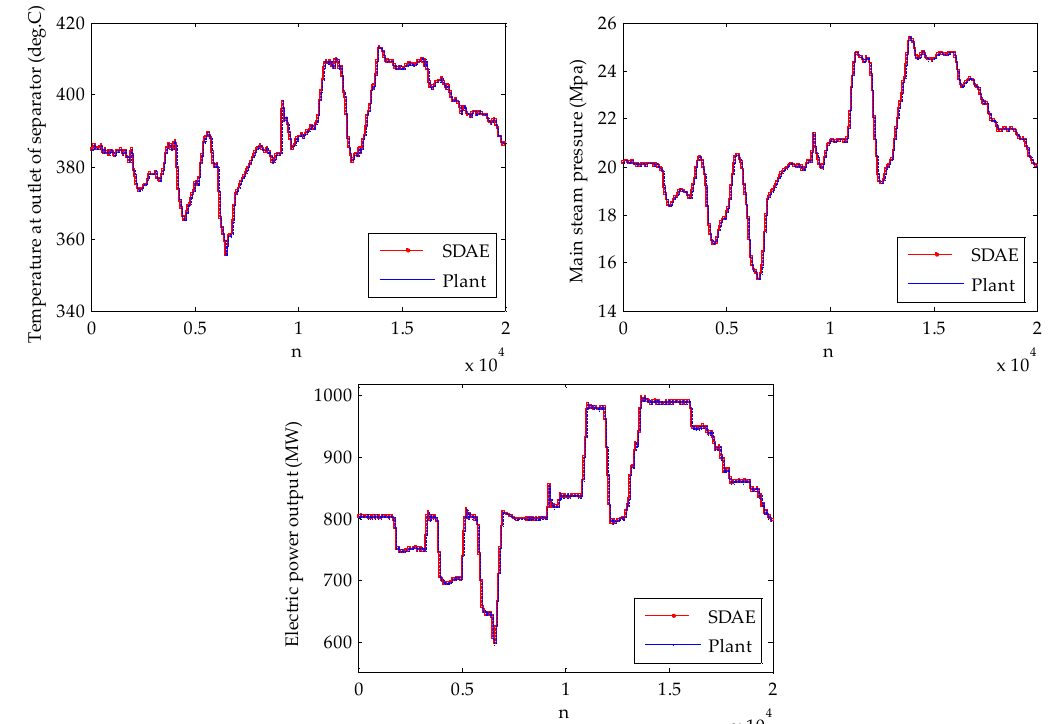
Figure 9. A comparison of the boiler system and the SAE model (training).